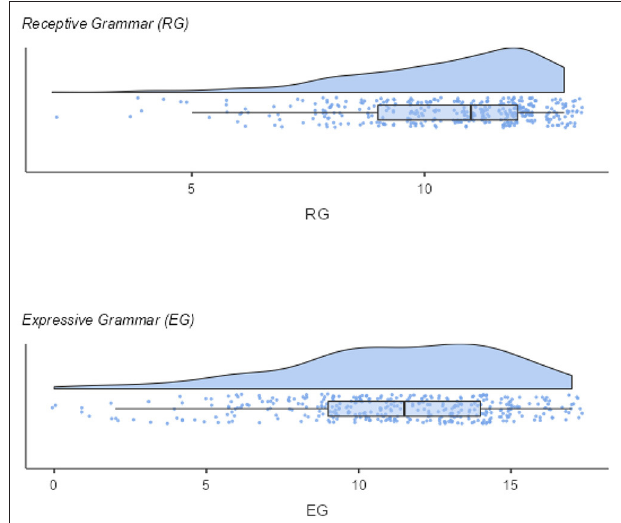
FIGURE 1 | Distribution of the screening